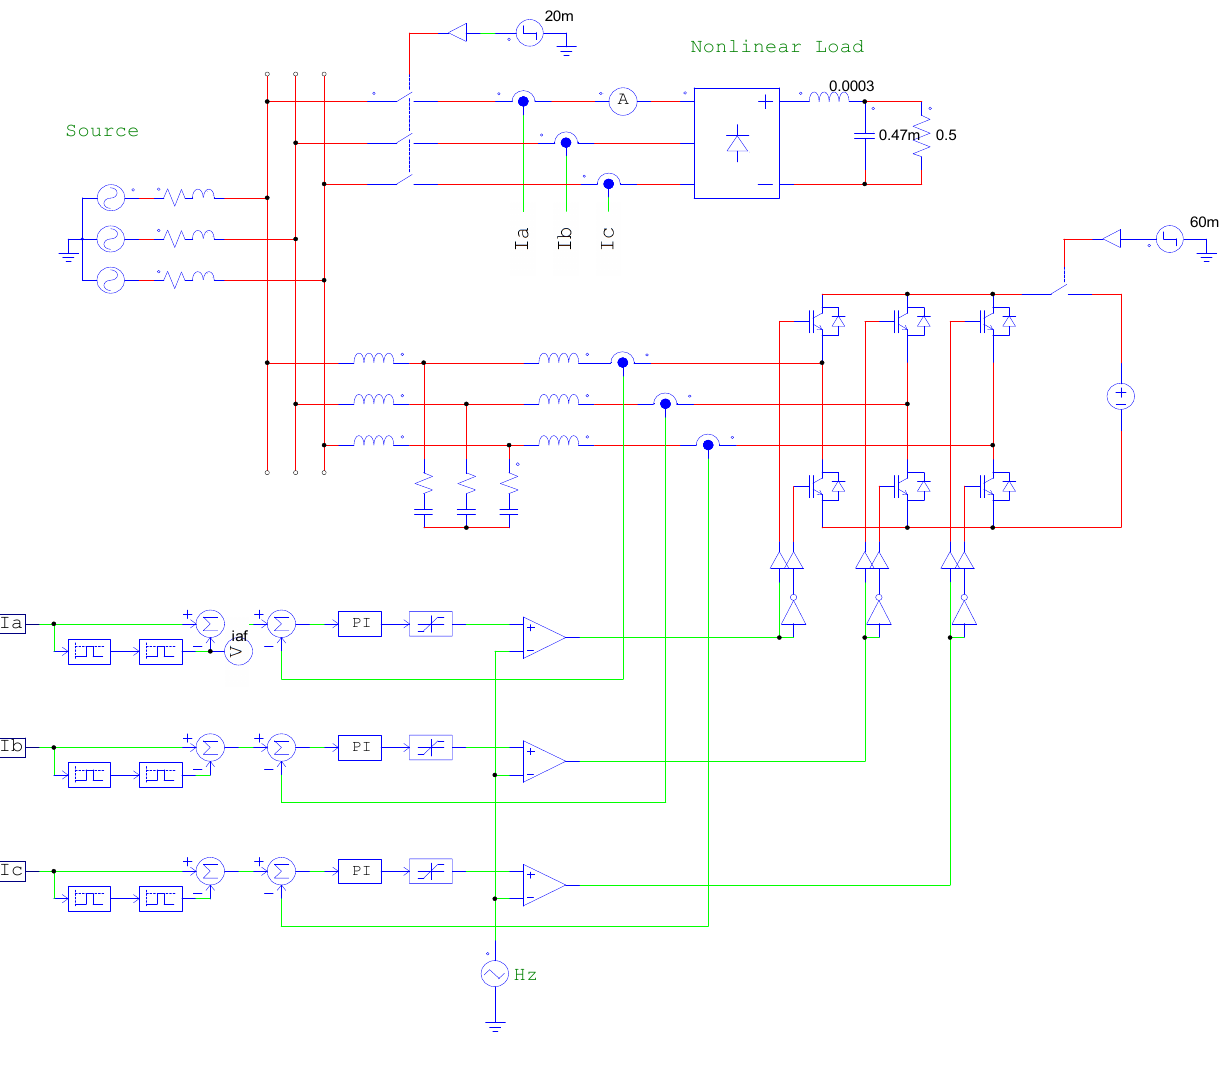
Figure 5. Block diagram of the proposed compensation scheme. PI: proportional-integral.